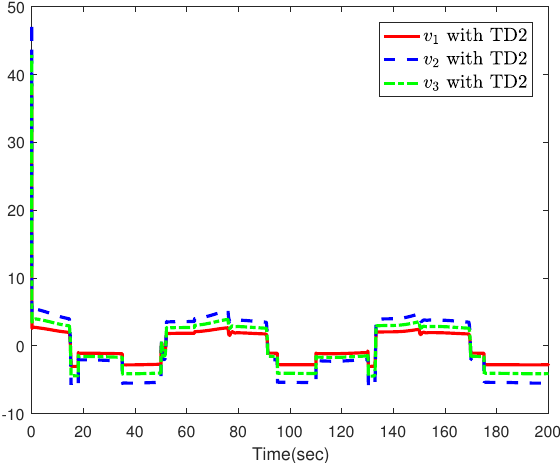
Figure 14. Control effect of System (3) without stochastic noise under